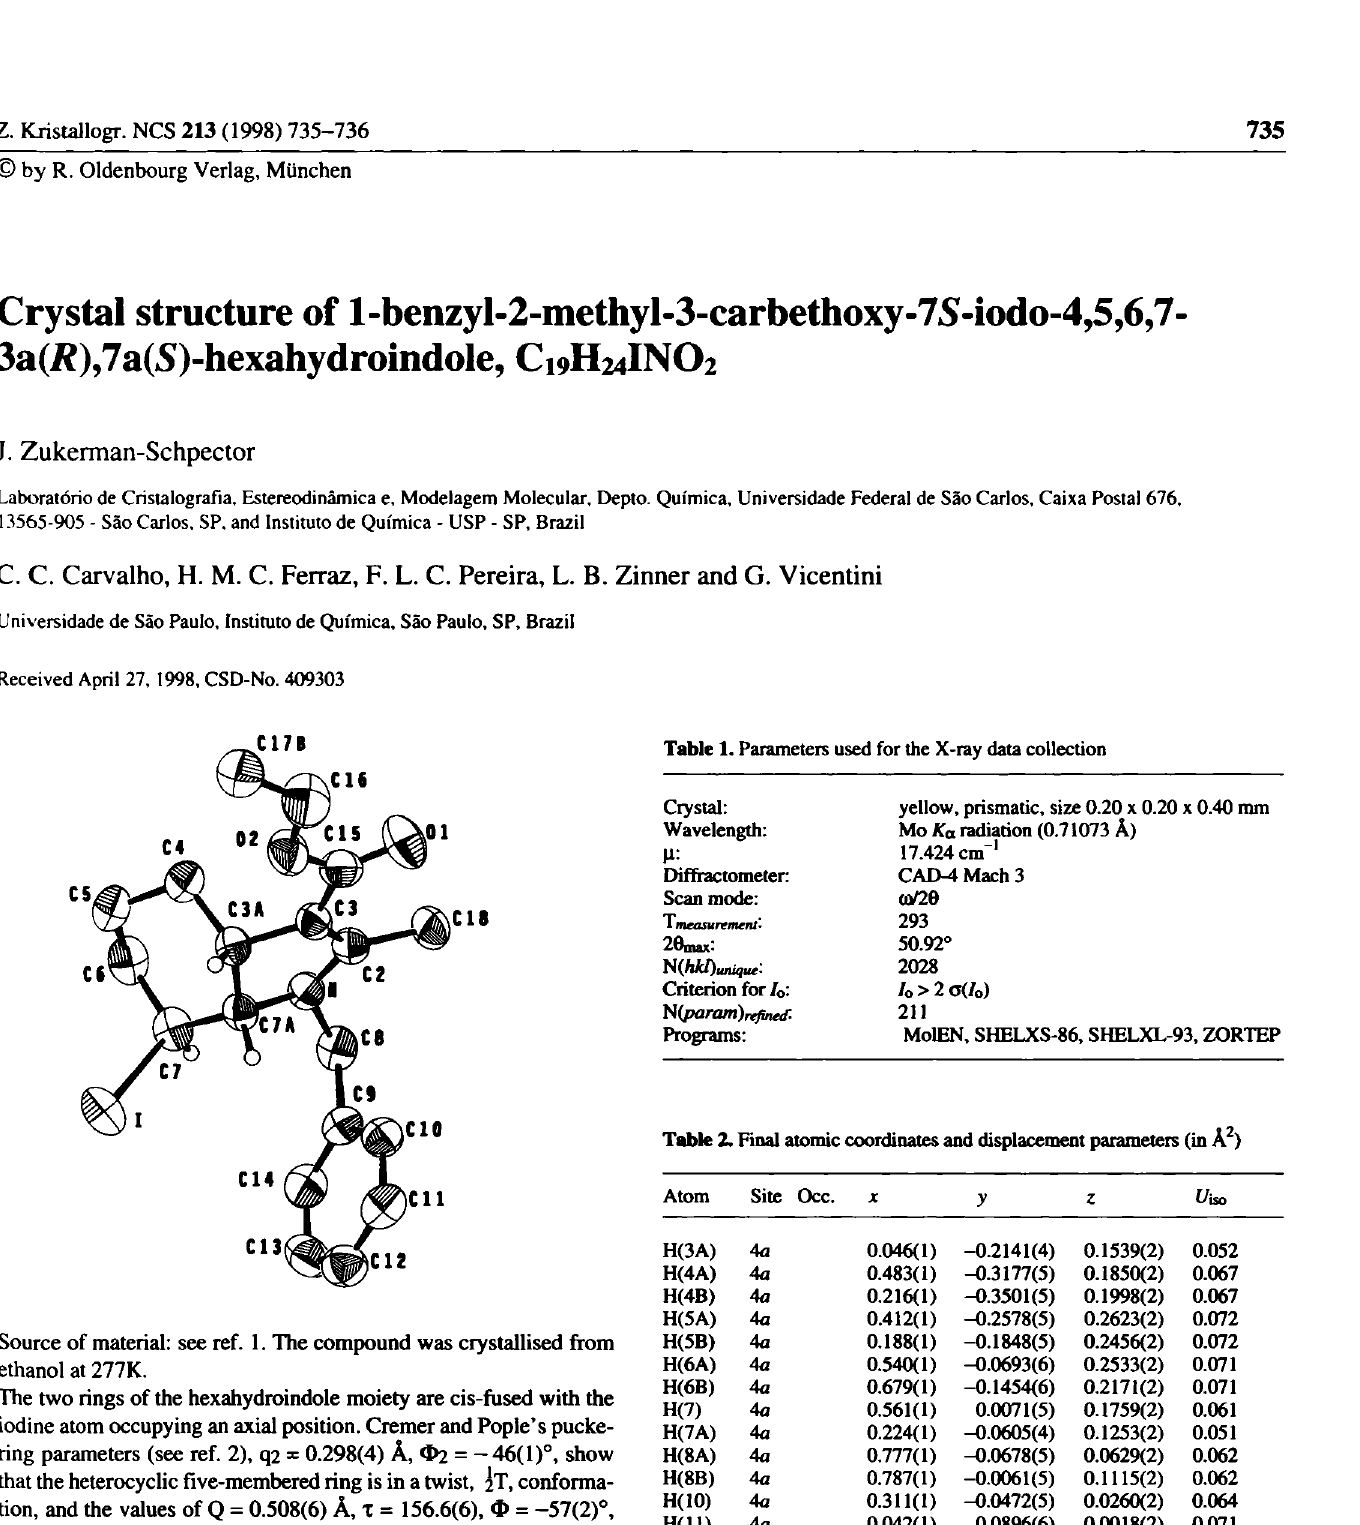
Table 2. Final atomic coordinates and displacement parameters (in